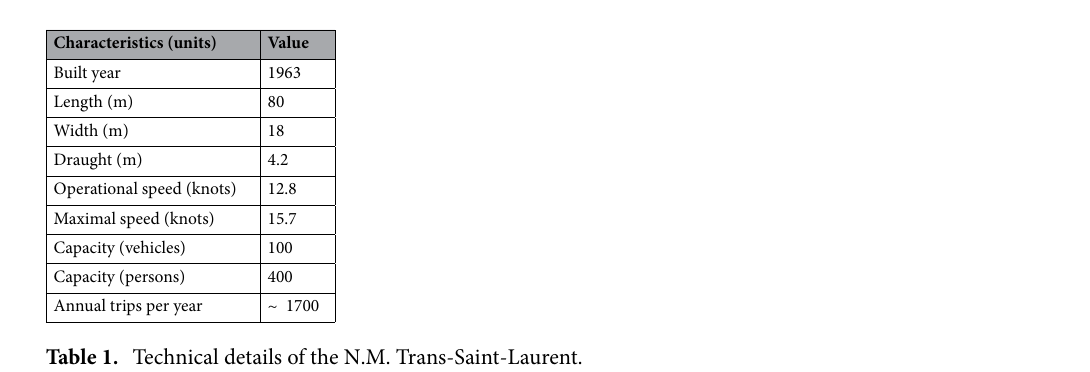
Figure 1. N.M. Trans-Saint-Laurent’s current route between Rivière-du-Loup and Saint-Siméon. The zone of interest where the hydrophone was deployed is located west of the Rivière-du-Loup harbor. Hatched polygons show the SLE beluga’s high-residency areas.